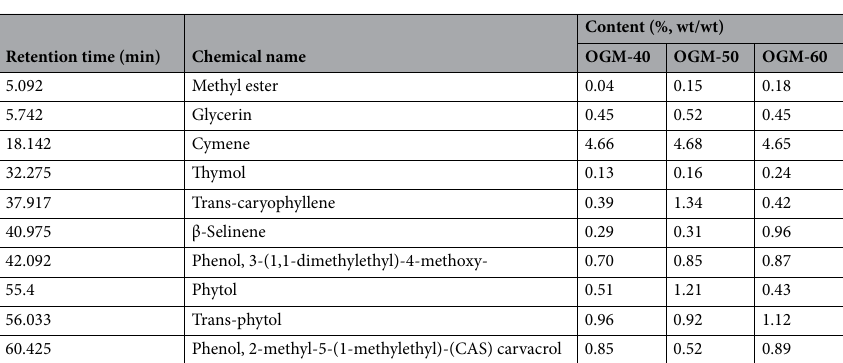
Table 2. Chemical profiling for methanolic extract of O.